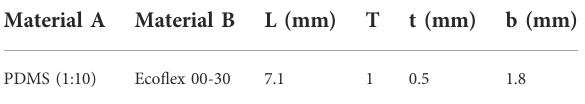
TABLE 3 Geometrical description and material composition of the balloon actuator that was set as the standard.